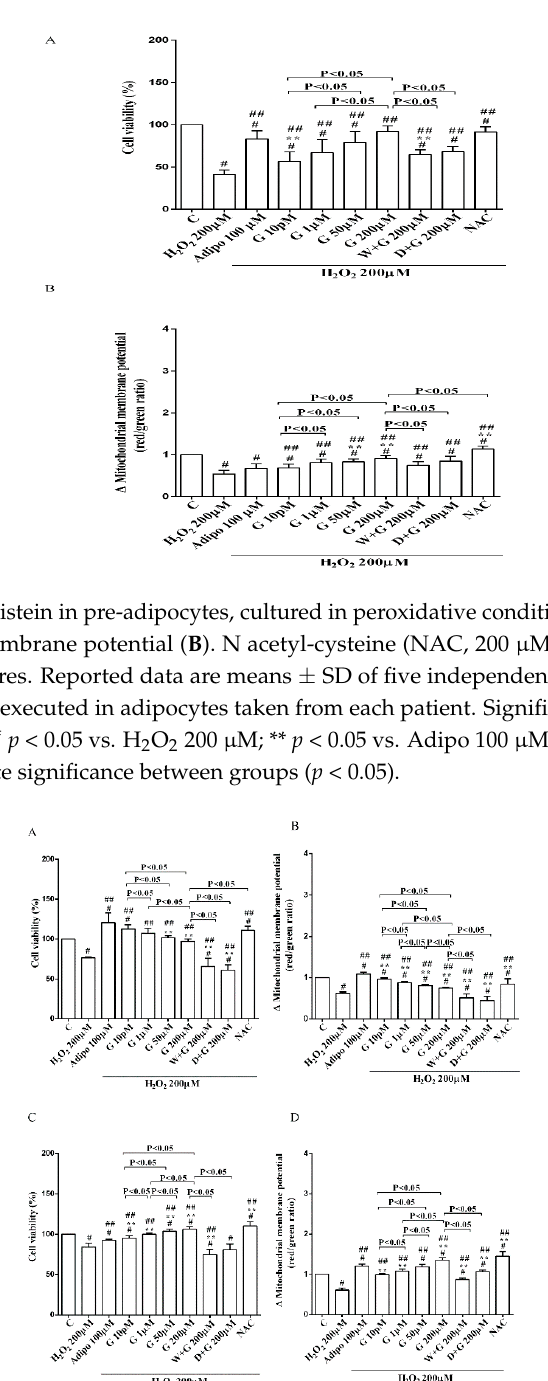
Figure 5. Effects of genistein in white adipocytes, cultured in peroxidative condition, on cell viability ( A ) and mitochondrial membrane potential ( B ), and in brown adipocytes, on cell viability ( C ) and mitochondrial membrane potential ( D ). Abbreviations are as in previous figures. Reported data are means ± SD of five independent experiments for each experimental protocol executed in adipocytes taken from each patient. Significance between groups: # p < 0.05 vs. control; ## p < 0.05 vs. H 2 O 2 200 µM; ** p < 0.05 vs. Adipo 100 µM + H 2 O 2 200 µM. Short square brackets indicate significance between groups ( p < 0.05).